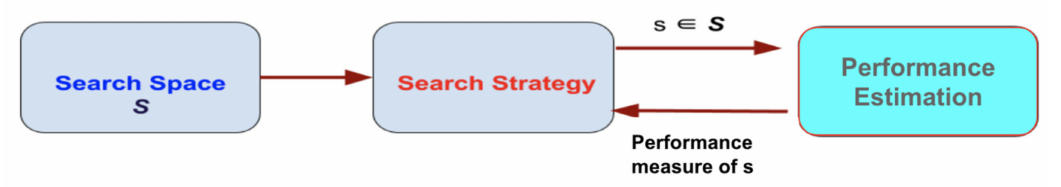
Figure 2. The three neural architecture search